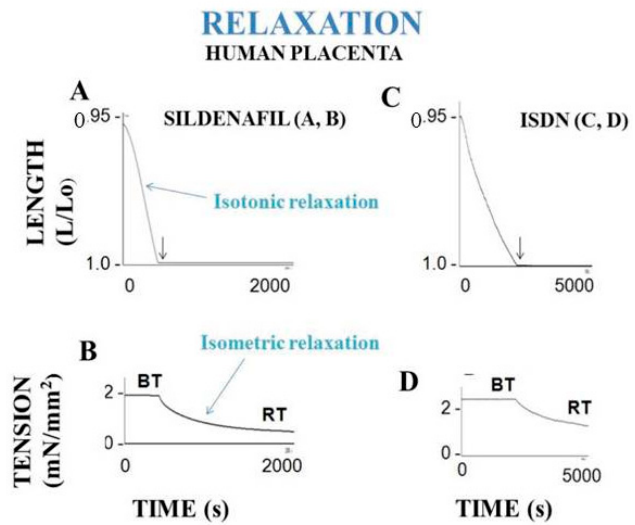
Figure 6. Relaxation of human placental stem villi. When maximum shortening length is reached, relaxation is obtained by either decreasing the intracellular Ca 2+ concentration (by addition of Sildenafil or ISDN in the bath) or by inhibition of myosin CB (by BDM or BLE). Relaxing effect of Sildenafil is shown on panels A and B . Relaxing effect of ISDN is shown on panels C and D . Isotonic relaxation is followed by isometric relaxation.